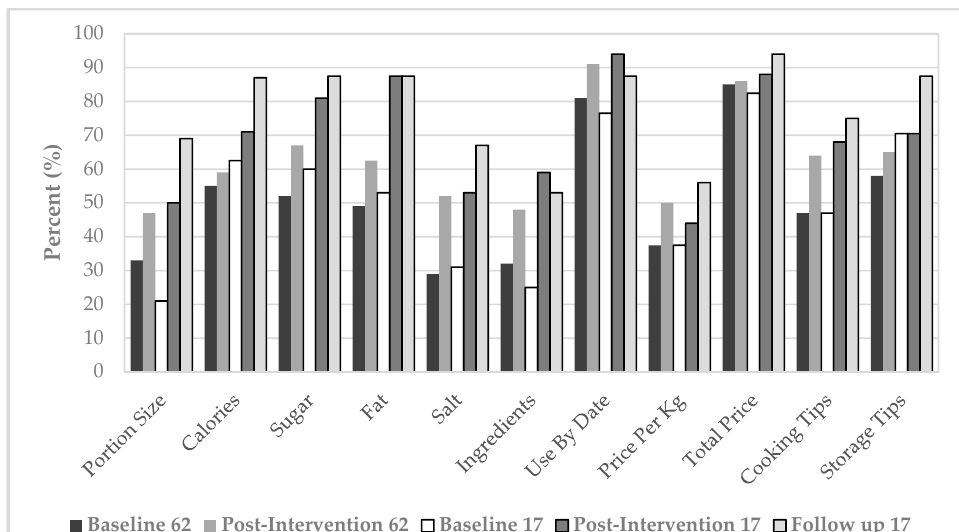
Figure 2. Food label elements checked at baseline and post-intervention ( n = 62) and 3–4 months follow-up ( n = 17).